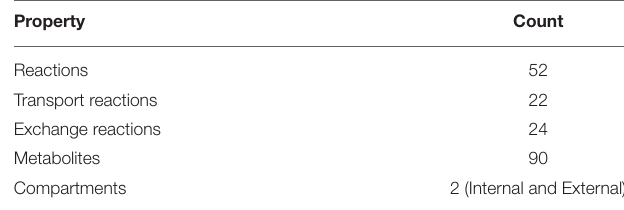
TABLE 3 | Properties of FBA model constructed from M7